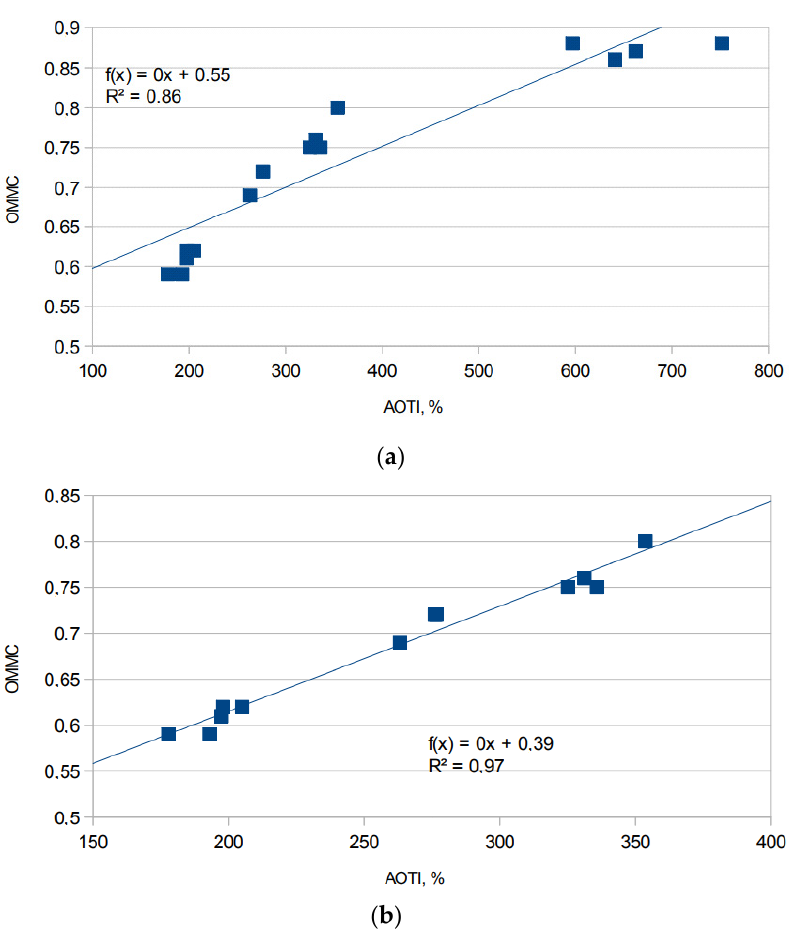
Figure 10. Relationship between AOTI and OMMC: ( a ) for all the tested fabrics 1A–8A and 1B–8B; ( b ) for the tested fabrics 1A–8A and 5B–8B .